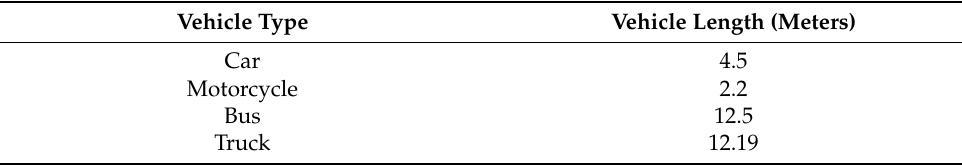
Table 5. Common vehicle length in